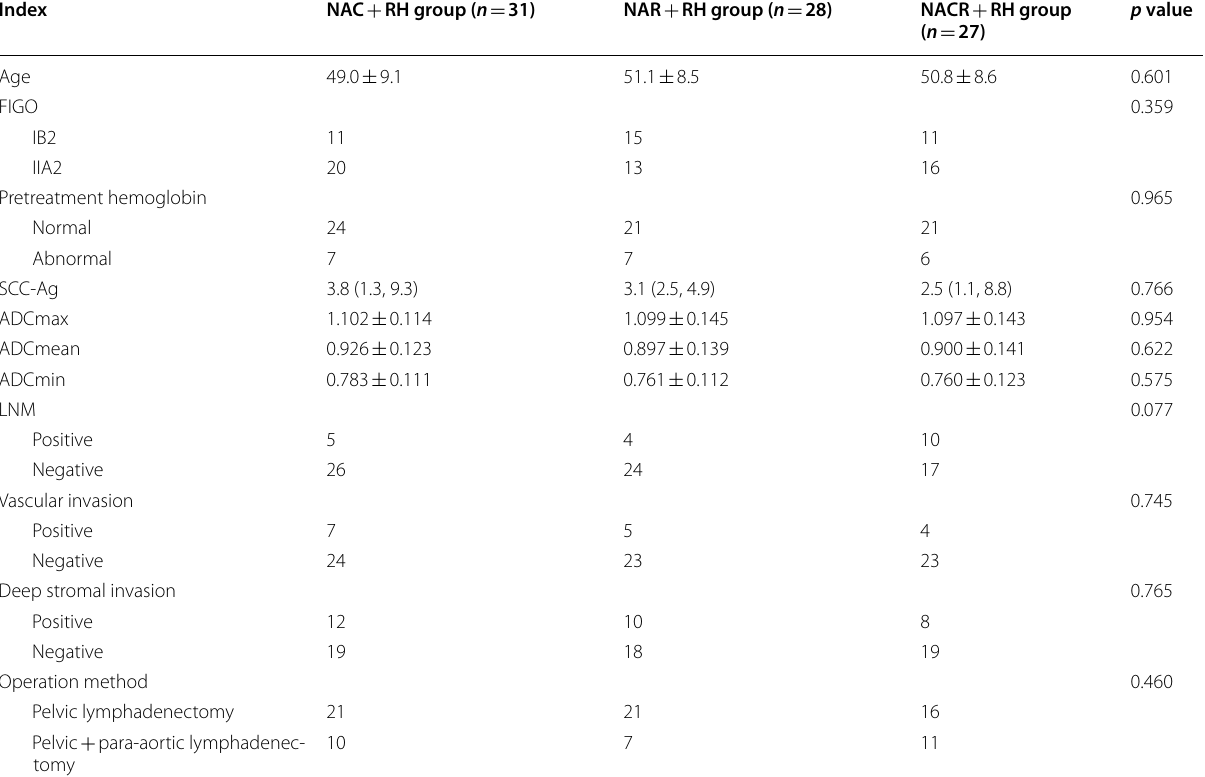
Table 2 Comparison of clinical indices, histopathologic factors and imaging indices among three different neoadjuvant therapy modalities followed by radical hysterectomy